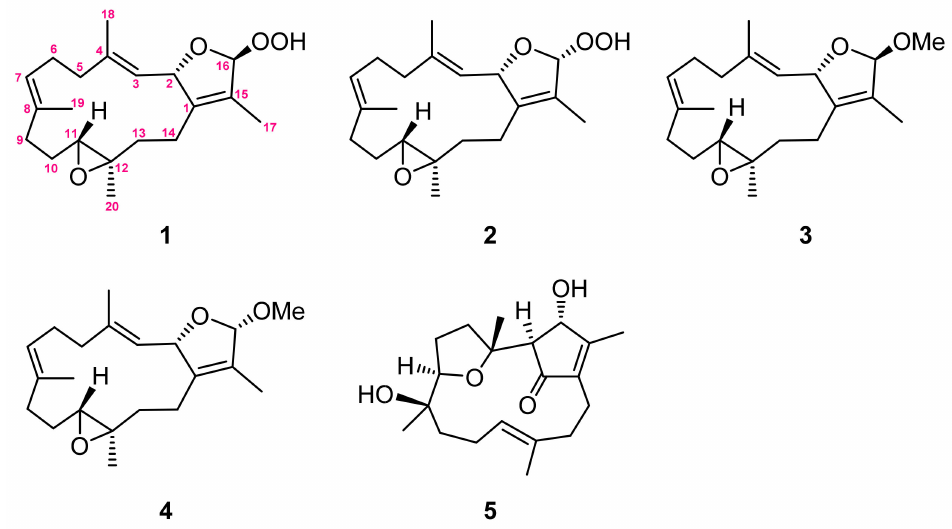
Figure 1. Structures of metabolites 1 – 5